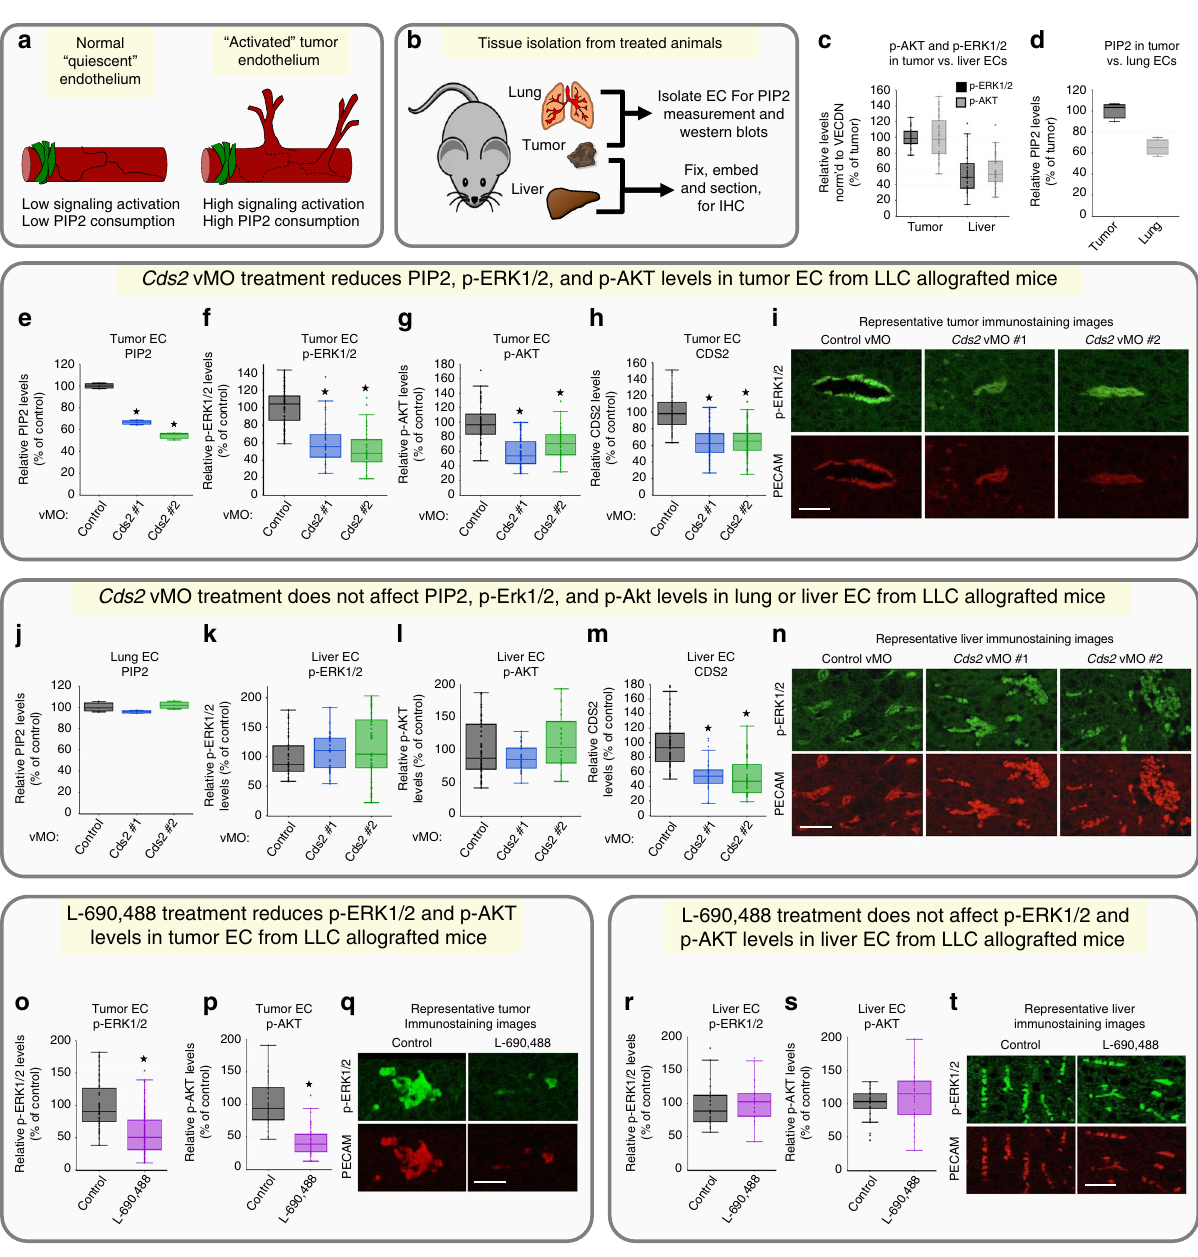
Fig. 4 Systemic anti-PIP2 recycling therapies suppress VEGFR2 downstream signaling in LLC tumor models. a Model for signaling in activated versus quiescent endothelium. b Diagram illustrating tissues isolated from mice and their use. c Quanti fi cation of vascular phospho-ERK1/2 (black bars) and phospho-AKT (gray bars) levels in immunostained liver or tumor tissue from LLC-allografted control animals ( n = 8). d ELISA measurement of PIP2 levels in lung or tumor endothelial cells from LLC-allografted control animals. Data is the average of three experimental replicates. e – n Cds2 vMO-treated, LLC- allografted mice. Quanti fi cation of PIP2 levels by ELISA in tumor ( e ) or lung ( j ) endothelial cells isolated from the same LLC-allografted animals. Data per treatment condition is graphed as the average of three experimental replicates. The ELISA measurements are normalized to whole cell tubulin lysates collected at the start of the lipid isolation procedure. Quanti fi cation of vascular phospho-ERK1/2 ( f , k ), phospho-AKT ( g , l ) and CDS2 ( h , m ) levels from immunostained sections of tumor ( f – h ) or liver ( k – m ) tissue collected from the same LLC-allografted animals. For all immunostaining quantitation experiments: three images per individual tumor or liver were acquired and signal intensity measured for all groups. A minimum of two slide sections from each tumor or liver (taken from sections at least 10 slices apart) were utilized for independent analysis. Tumors, n = 10; Livers, n = 5. i , n Representative images of tumor ( i ) or liver ( n ) sections from control or Cds2 vMO-treated mice, double immunostained with phospho-ERK1/2 antibody (green images) and PECAM antibody (red images). o – t L-690,488-treated, LLC-allografted mice. Quanti fi cation of vascular phospho-ERK1/2 ( o , r ) and phospho-AKT ( p , s ) levels from immunostained sections of tumor ( o , p ) or liver ( r , s ) tissue collected from the same LLC-allografted animals. q , t Representative images of tumor ( q ) or liver ( t ) sections from control (DMSO) or L-690,488-treated mice, double-immunostained with phospho-ERK1/2 antibody (green images) and PECAM antibody (red images). Control tumors, n = 8; L-690,488 tumors, n = 16; control livers, n = 4; L-690,488 livers, n = 8 p ≤ 0.05, error bars ± SEM. Star indicates signi fi cance from control ( t -test). Bars = 200 μ m. Box plots are graphed showing the median versus the fi rst and third quartiles of the data (the middle, top, and bottom lines of the box, respectively). The whiskers demonstrate the spread of data within 1.5x above and below the interquartile range. All data points are shown as individual dots, with outliers shown above or below the